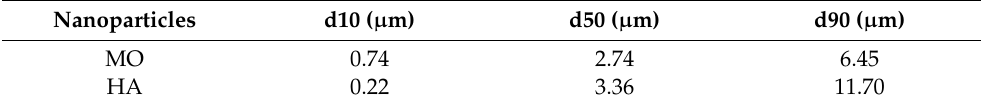
Table 2. Particle size distribution of